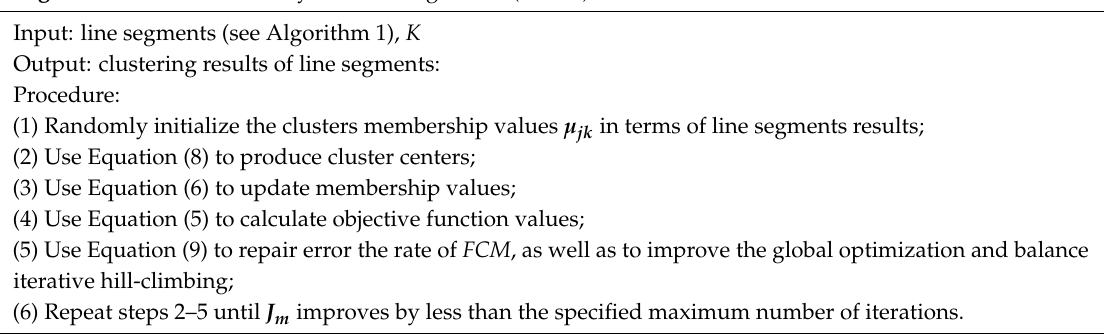
Algorithm 2. The novel fuzzy C-means algorithm (FCML)